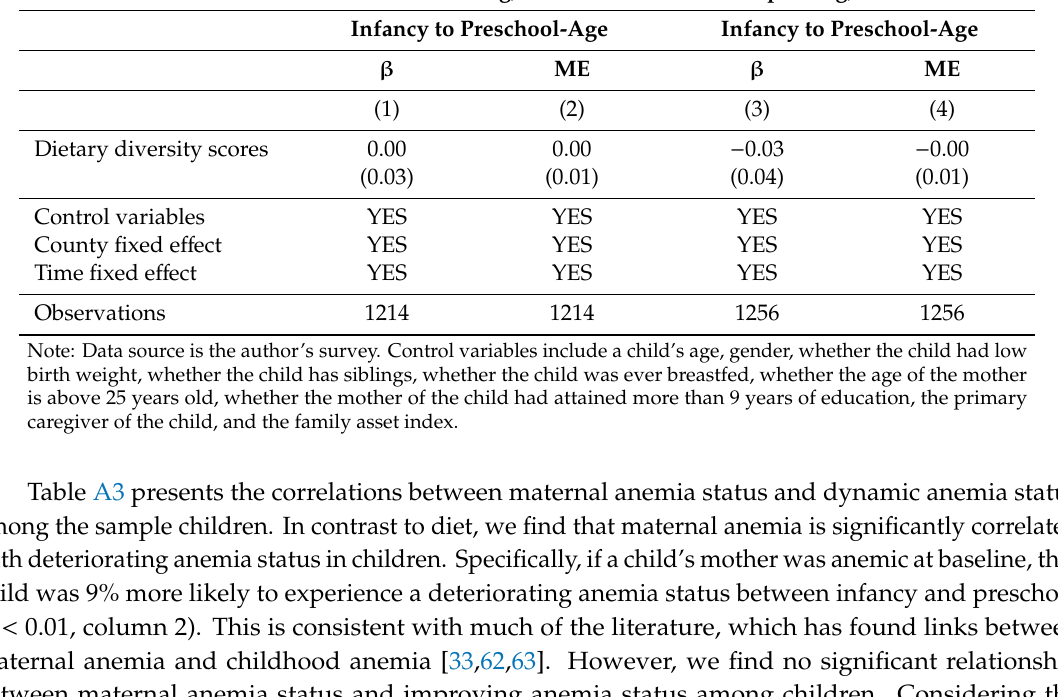
Table A2. Multivariate analysis of the association between dietary diversity and evolutionary paths. Variable